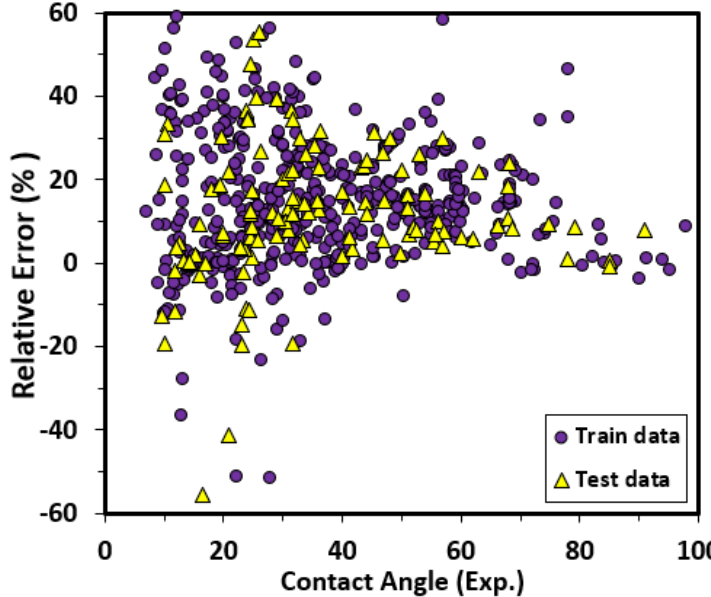
Figure 8. Relative error distribution of the proposed correlation.